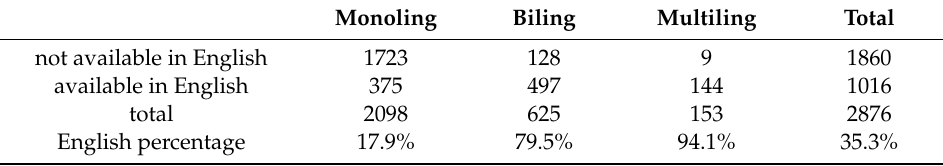
Table A36. English language availability (lu).